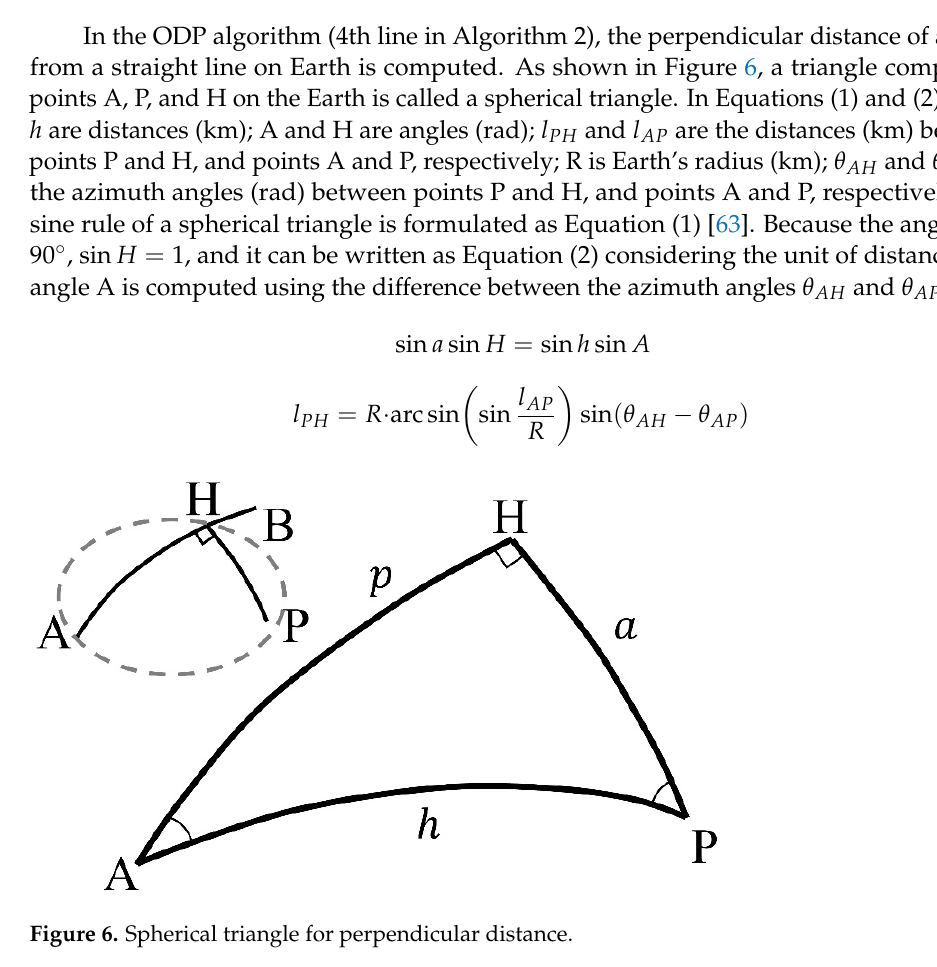
Figure 6. Spherical triangle for perpendicular distance.